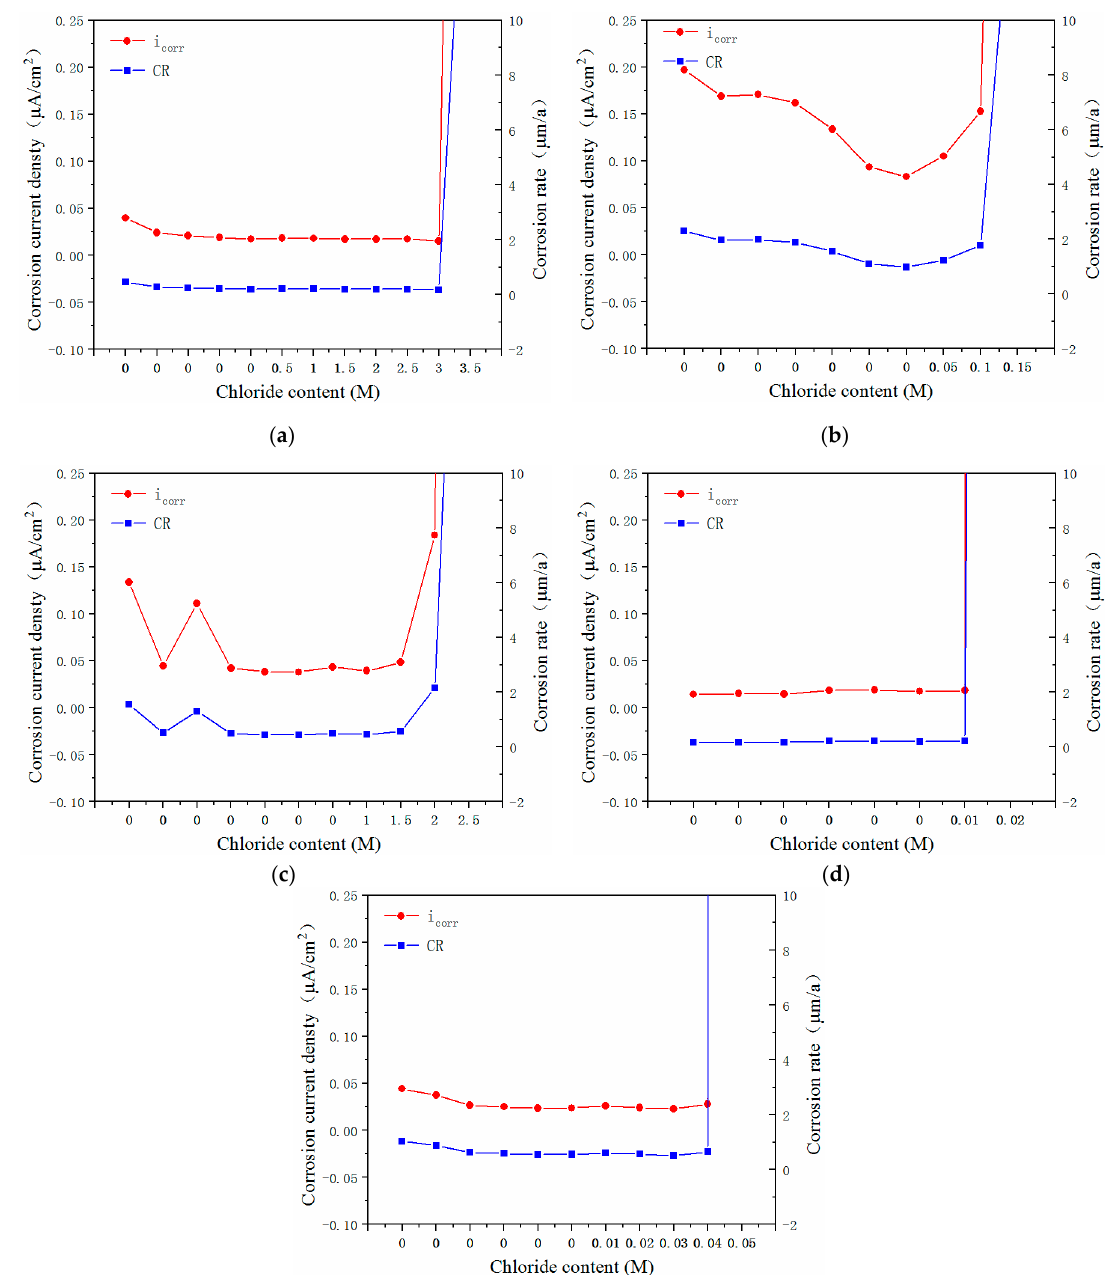
Figure 8. Influence of chloride content on the icorr and CR values of the steels: ( a ) novel type-2205 duplex stainless steel; ( b ) type-2205 duplex stainless steel ( c ) type-316 austenitic stainless steel; ( d ) HRB400; ( e ) HRB500.